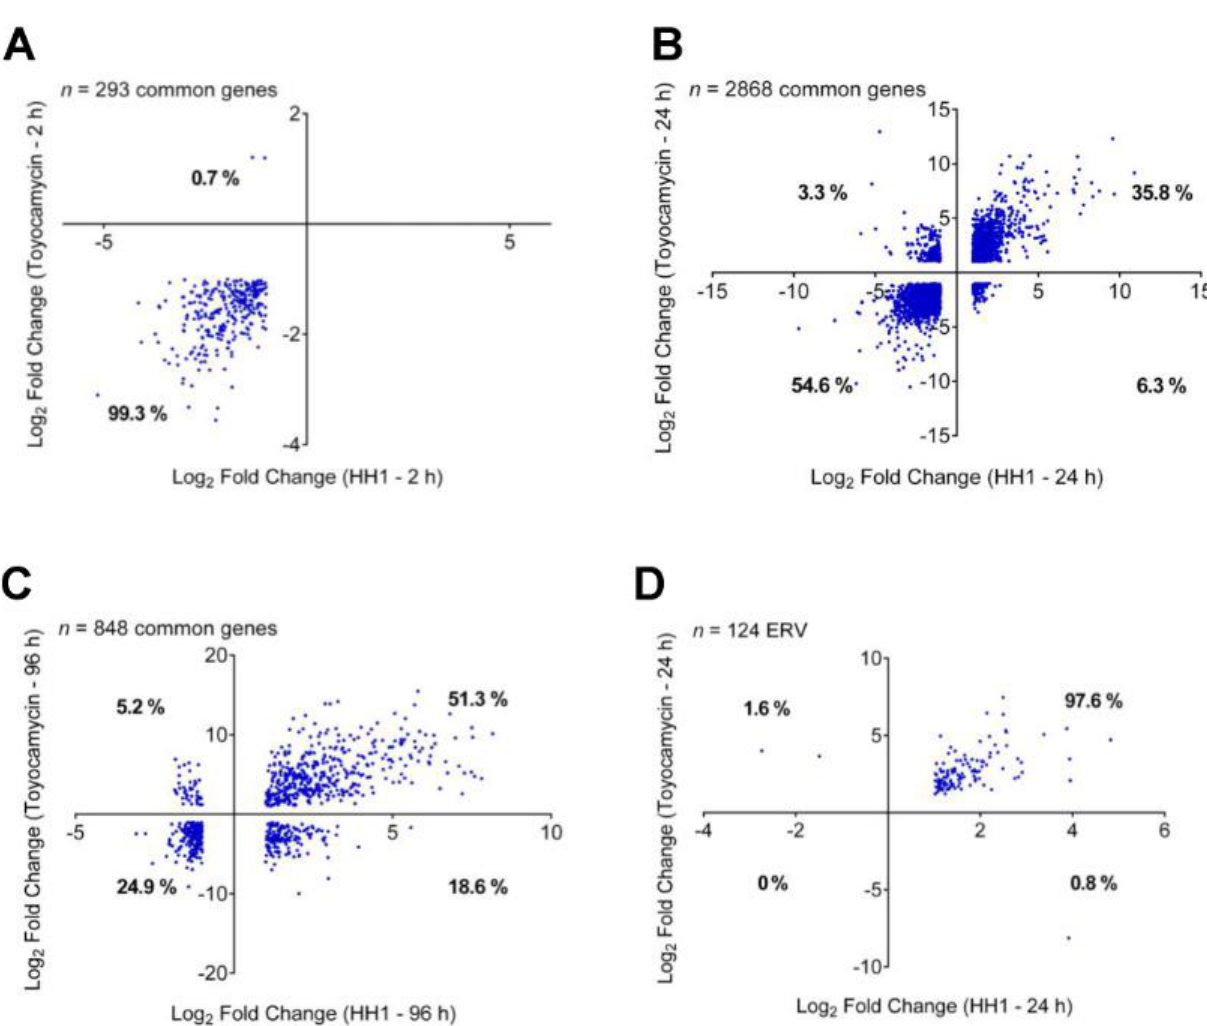
Figure 3. Common gene regulation between toyocamycin treatment and HH1 treatment in YB5 cells. RNA-seq data sets were merged to compare the expression values of common genes differentially regulated by toyocamycin and HH1 in YB5 cells (downregulated genes with Log2FC < – 1 and up-regulated genes with Log2FC > 1, p -adjusted values < 0.05). Gene expression data sets are presented